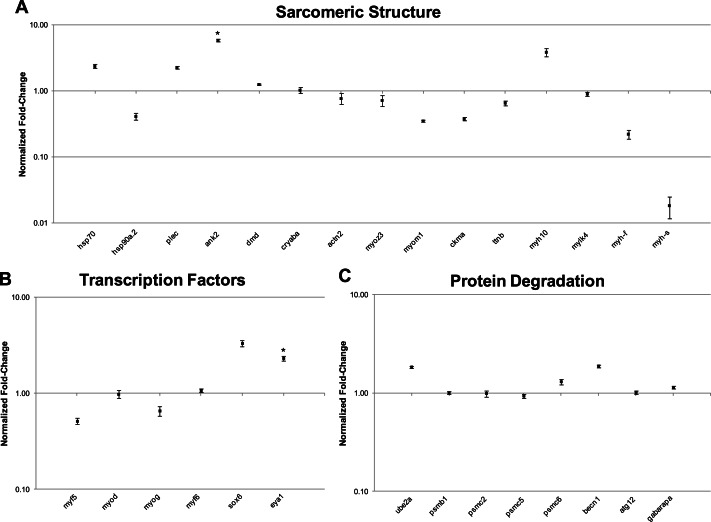
qRT-PCR analysis of 29 transcripts associated with the expression of sarcomeric genes.Plots illustrating fold-change differences between EO and muscle in S. macrurus (n = 4). (A) Fold-change differences of 15 transcripts associated with sarcomere formation and structure. (B) Fold-change differences of six transcription factors associated with regulating the expression of sarcomeric genes. (C) Fold-change differences of eight genes involved in protein degradation pathways. Data are shown as fold-changes ± standard error, graphed on a logarithmic scale with values >1 indicating increased expression in EO relative to muscle and values <1 indicating decreased expression in EO relative to muscle. Data points marked with asterisks are significantly differentially expressed between EO and muscle (adjusted p-value < 0.05).